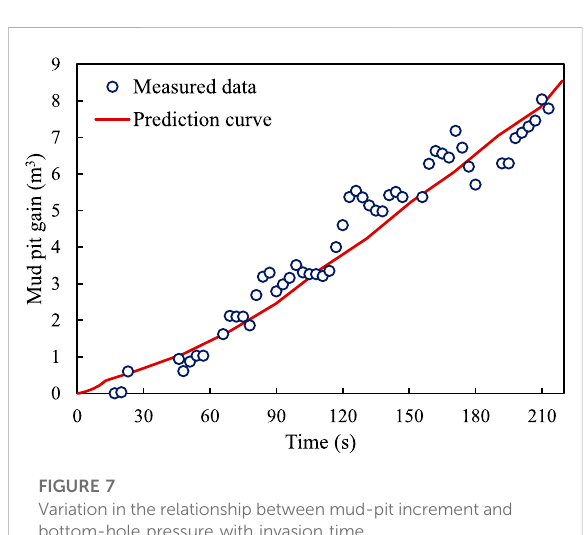
TABLE 2 Speci fi cations of the example well.